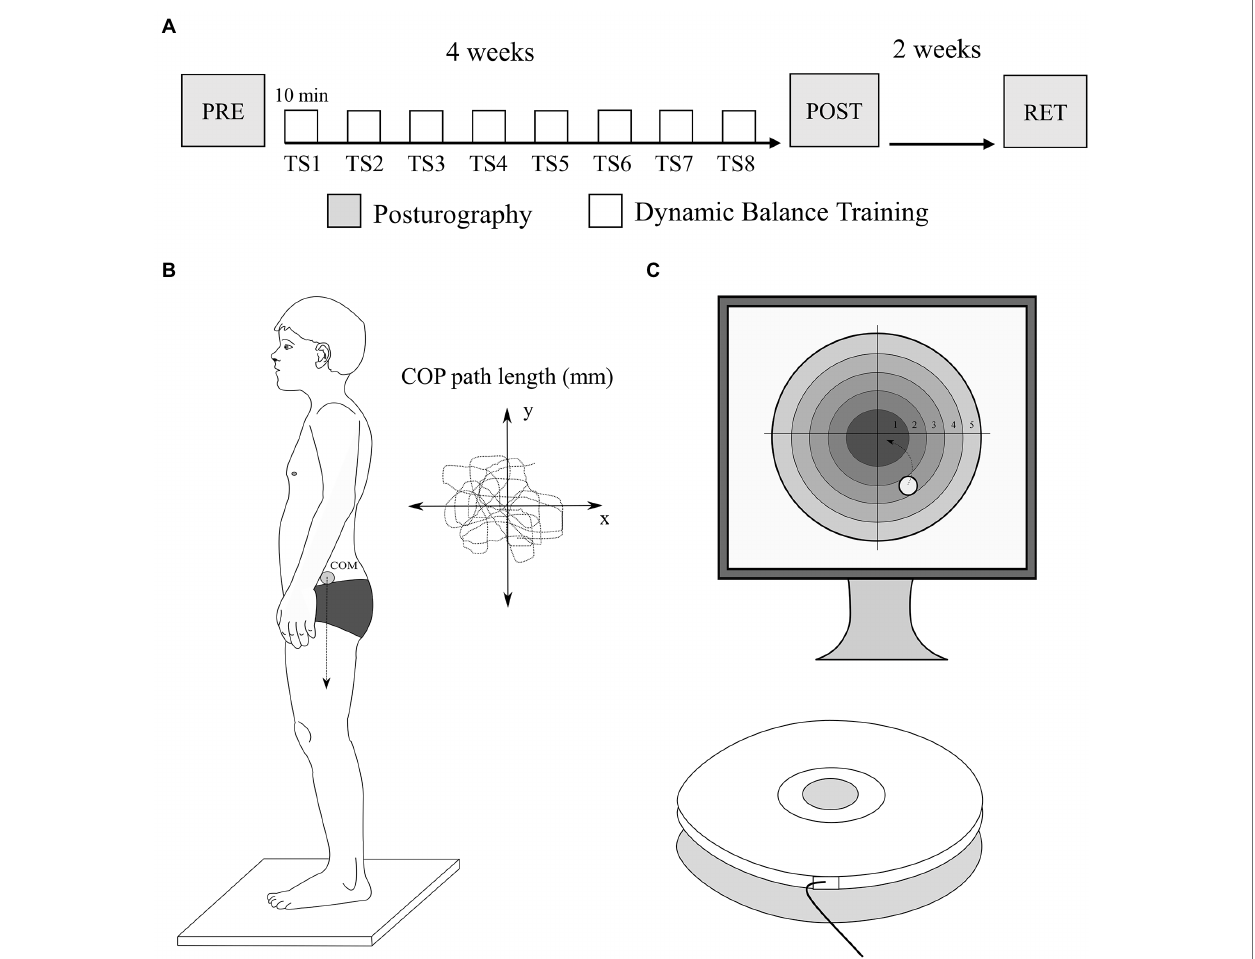
FIGURE 1 | Experimental design and setup. (A) Dynamic balance training was performed for 4 weeks over eight training sessions (TS), each lasting approximately 10 min. Before and after the training period, postural stability was assessed in two-legged and one-legged stance conditions. Furthermore, 2 weeks later, retention was assessed again using posturography. (B) Posturography was performed using the Wii Balance Board. The total center of pressure (COP) path length was recorded over a trial length of 20 s as main outcome parameter of postural stability. (C) Dynamic balance training was performed with the challenge disk. The main goal concerning the entire dynamic balance training was to track a red circular target zone with a green point cursor (corresponding to the COP) by way of shifting the bodyweight in different directions. The cursor movement could be seen by the participants on a PC screen placed in front of